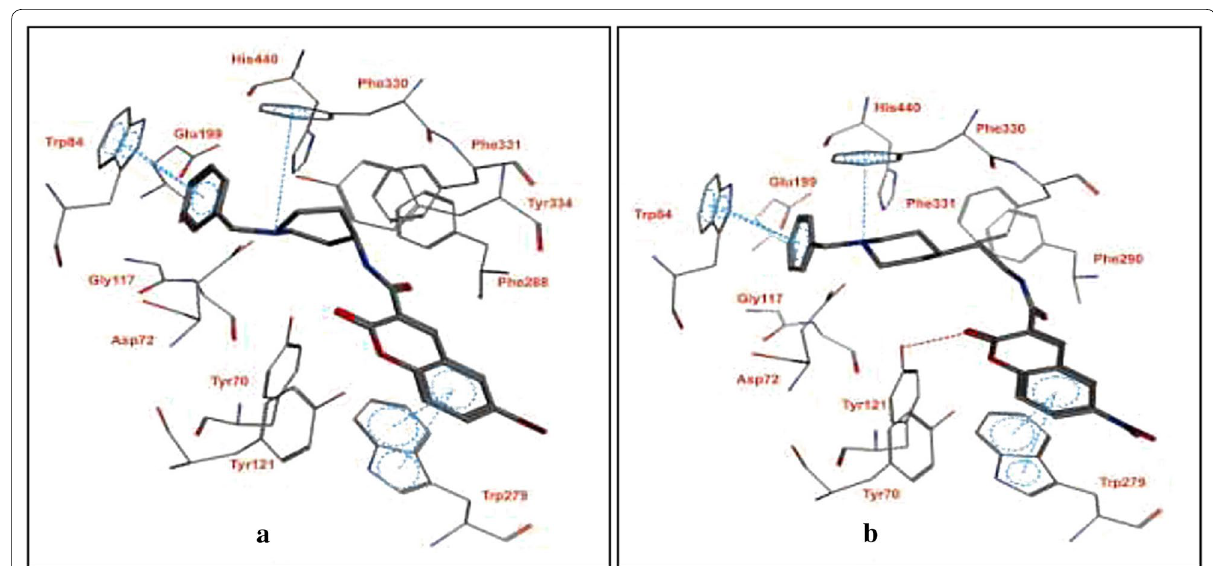
Fig. 19 a Representative model for interactions of compounds C13a . b C14a docked into the binding site of AChE. Hydrogen bond is indicated as red dotted line [10]